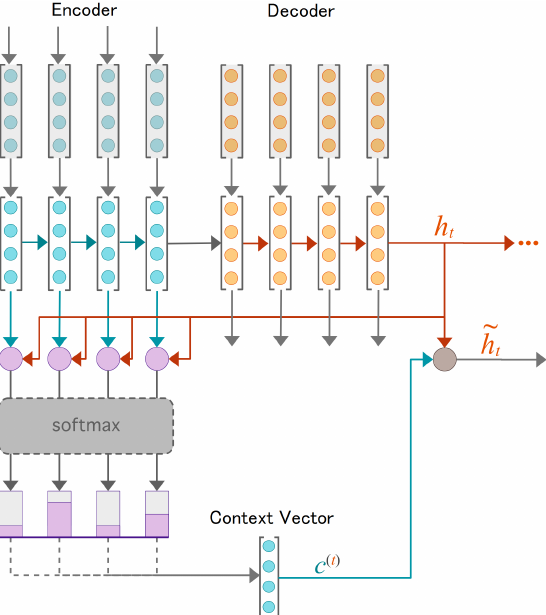
Figure 1. General overview of the network architecture, including a Seq2Seq encoder–decoder and attention